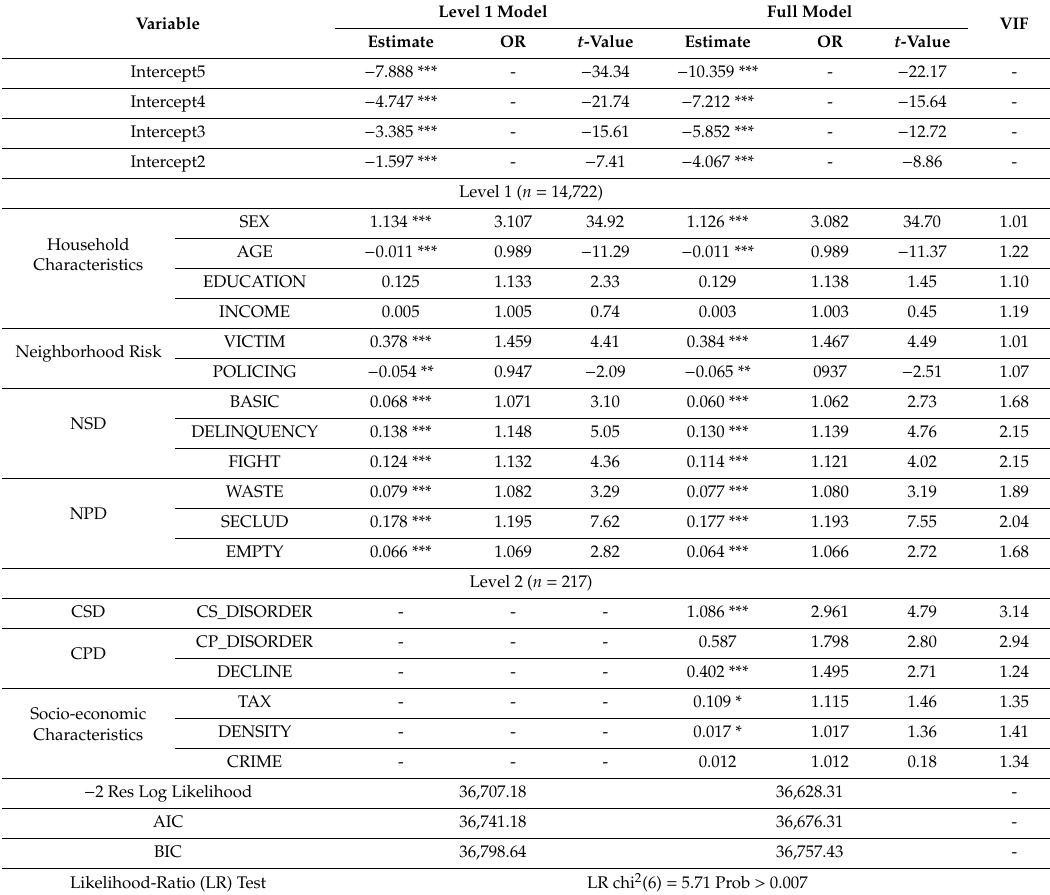
Table 7. Results of empirical